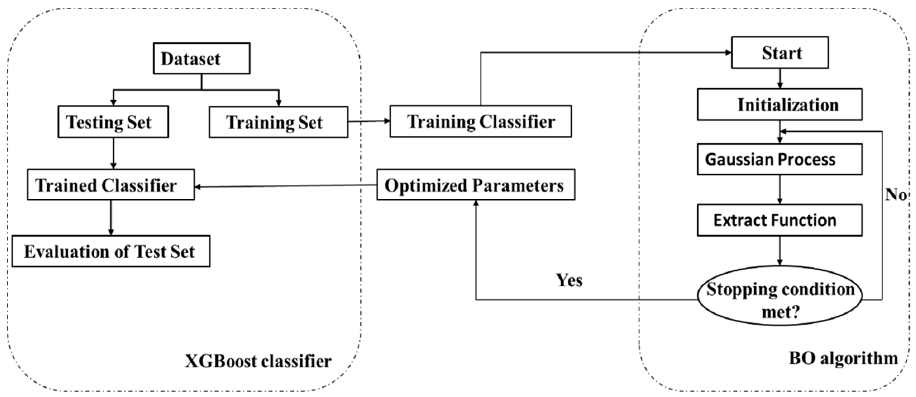
Figure 3. The procedure of the proposed ensemble technique.